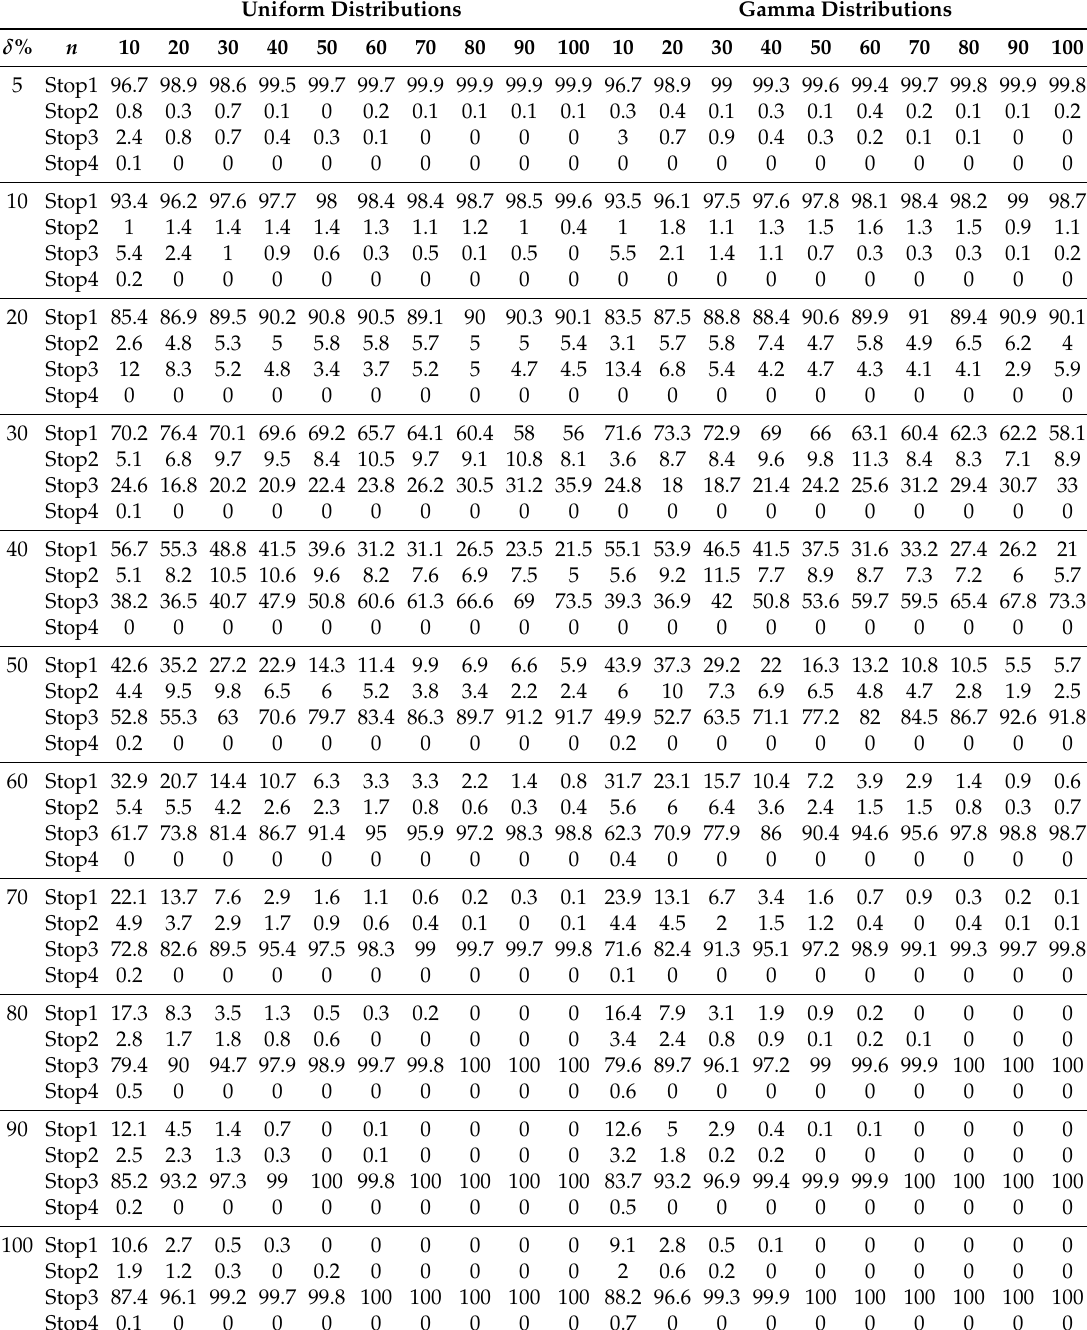
Table A2. Computational results for randomly generated instances with the ratio 0%:0%:20%:80% of the numbers of jobs in the subsets J 1 , J 2 , J 1,2 and J 2,1 of the job set J